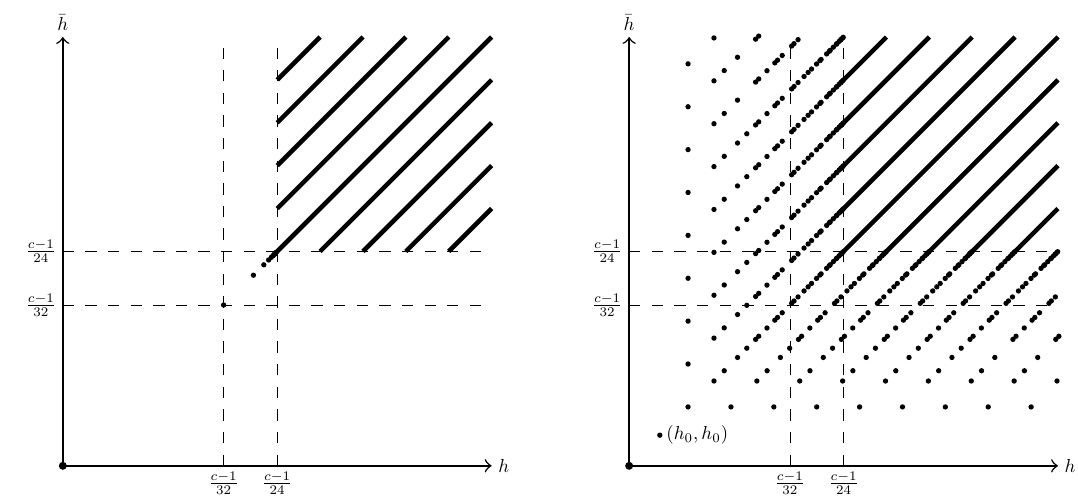
Figure 3. Left: the spectrum of Virasoro primary operators of the pure gravity partition function endowed with the conical defect states. There are no discrete Regge trajectories with an asymptotic twist below the black hole threshold, and the spectrum of twists is continuous above the black hole threshold. Right: a rough sketch of the spectrum of Virasoro primary operators of a generic irrational CFT with a light scalar operator with weight h 0 below c (cid:0) 1 . In this case there are a 32 (cid:12)nite, discrete set of in(cid:12)nite towers of multi-twist operators with asymptotic twist below the black hole threshold. This sketch is meant to be schematic, and merely capture the existence of the discrete multi-twist Regge trajectories below the black hole threshold | in a genuine CFT, the Regge trajectories are not exactly (cid:13)at (i.e. the multi-twist operators have anomalous dimensions at (cid:12)nite spin) and the spectrum of twists above the black hole threshold is only dense at large spin. Furthermore, the presence of the multi-twist Regge trajectories will serve to modify the black hole threshold in a spin-dependent way; see [25] for more